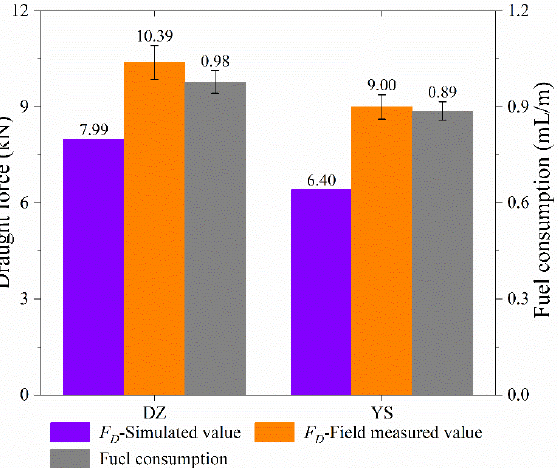
Figure 16. Comparisons of the simulated and field measured results in terms of the draught force and the fuel